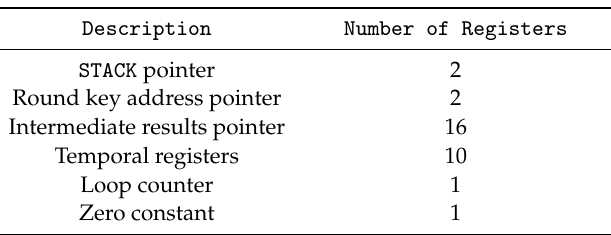
Table 3. Register utilization for